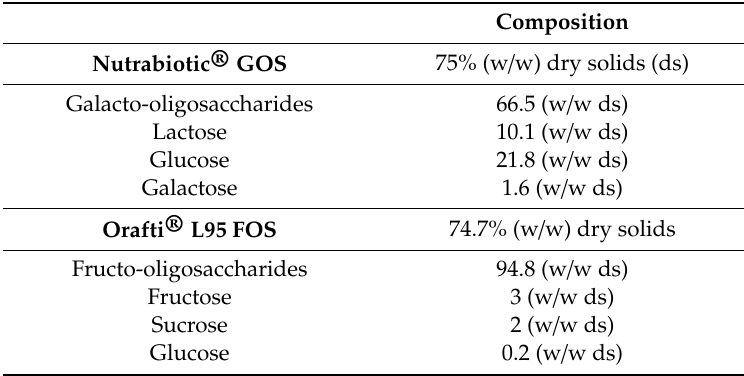
Table 1. Nutrabiotic ® galacto-oligosaccharides (GOS) and Orafti ® L95 fructo-oligosaccharides (FOS) syrup